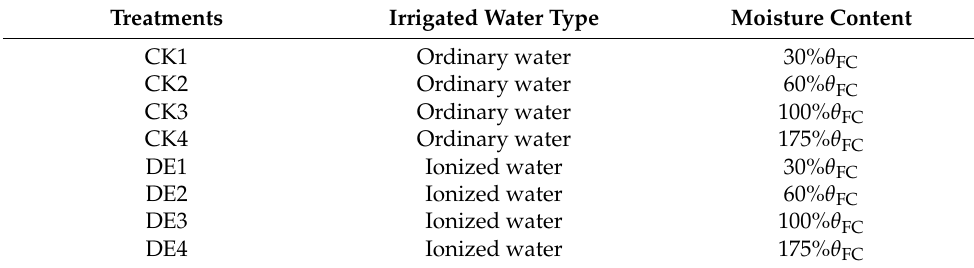
Table 1. Experimental treatment